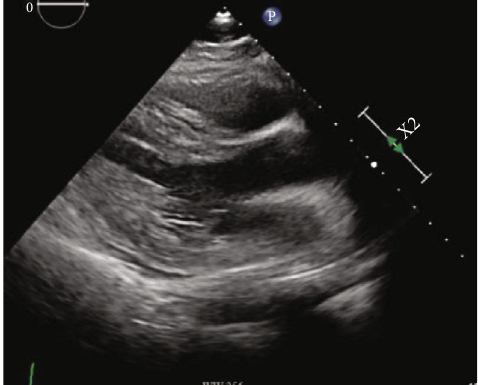
Figure 2: Transthoracic echocardiogram showed a small left ventricular cavity, thick left ventricular walls, and trivial pericardial e ff